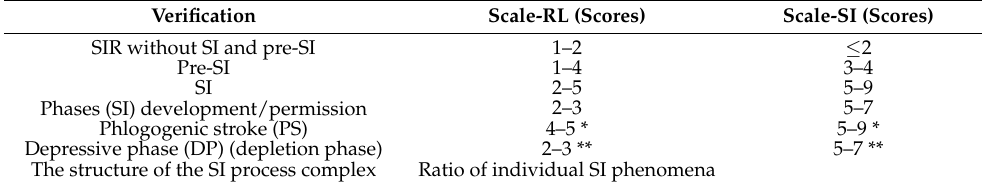
Table 3. Verification of SI phases using SI and RL integral scales.